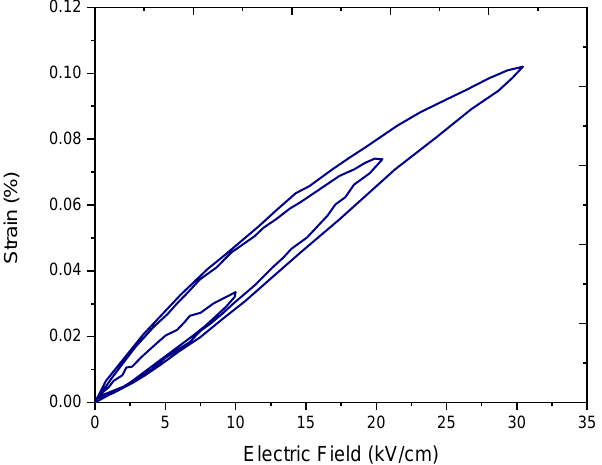
Figure 7. Strain-electric field curve of 0.96(K 0.5 Na 0.5 )NbO 3 -0.04CaZrO 3 +0.03Zr multilayer sample with nickel internal electrode, redrawn from [59].